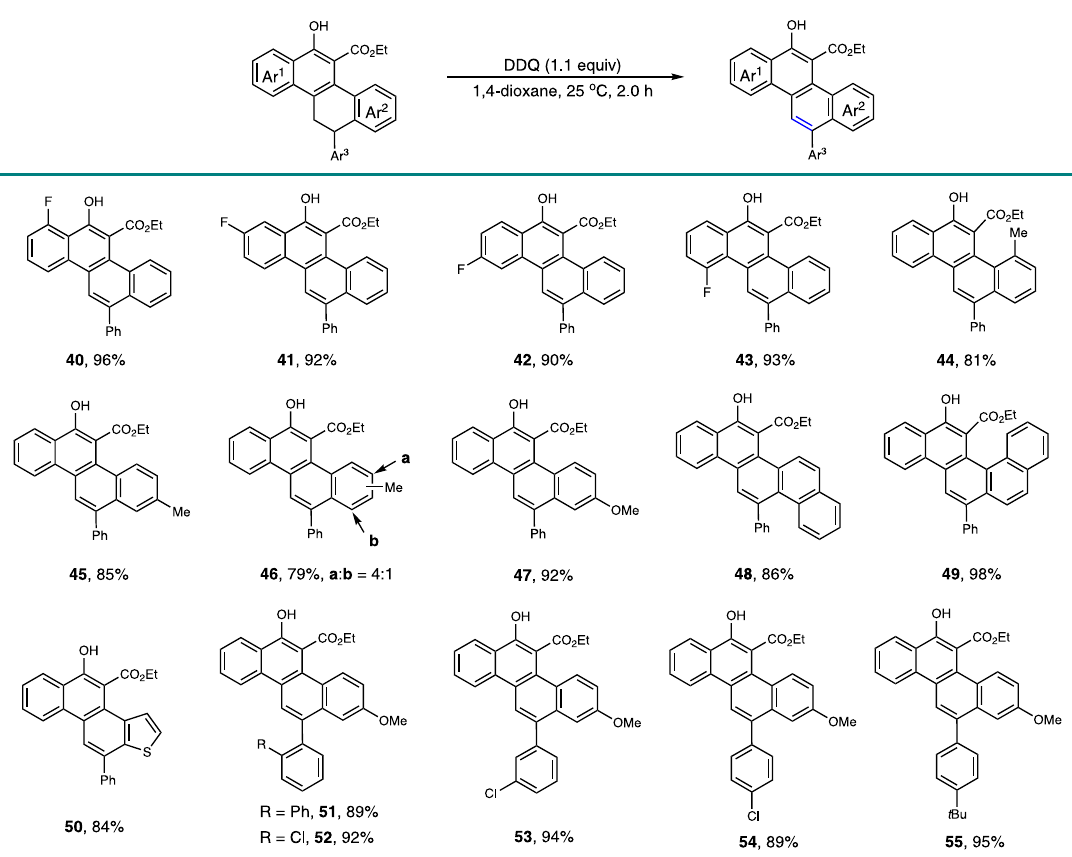
Fig. 4 Preparation of polycyclic aromatic hydrocarbons (PAHs). Reaction condition: the generated formal [4 + 2]-cycloaddition adducts (0.10 mmol), 2,3- Dicyano-5,6-dichlorobenzoquinone (DDQ, 25.0 mg, 0.11 mmol), and 1,4-dioxane (6.0 mL) were added in sequence at 25 °C, and the reaction mixture was stirred for 12 h under these conditions. Isolated yields are listed.